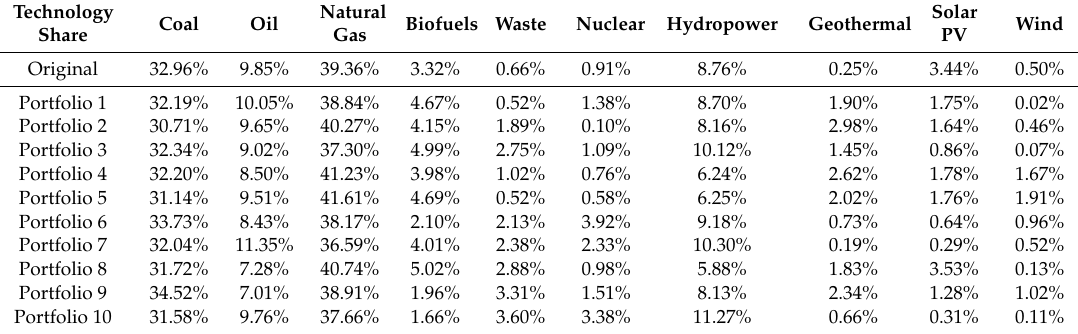
Table 15. 10 closest electricity generation portfolios to Japan’s current one (listed in increasing order of Euclidian